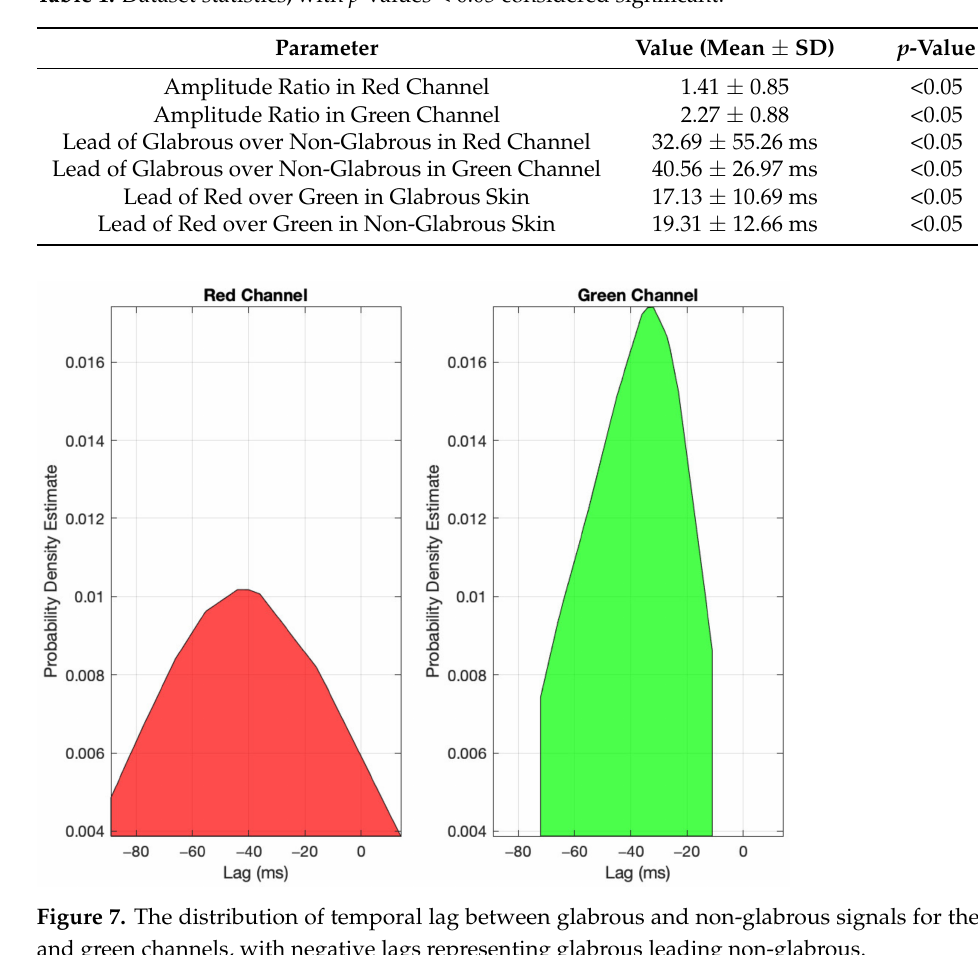
Table 1. Dataset statistics, with p -values < 0.05 considered significant.